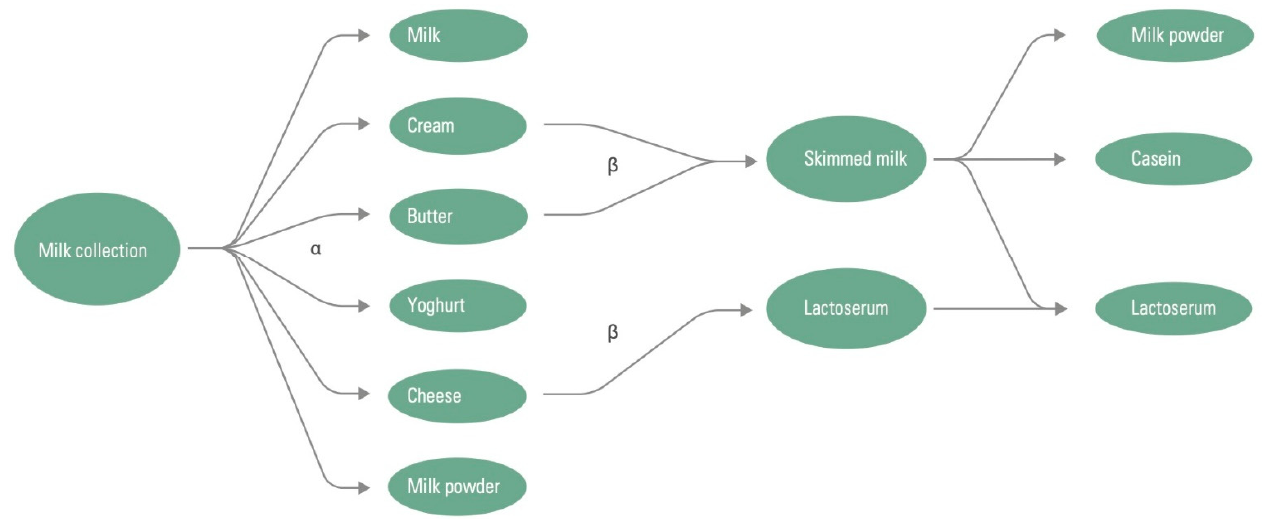
Figure 4. The structure of the milk industry as reconstructed in IAA_Calc.